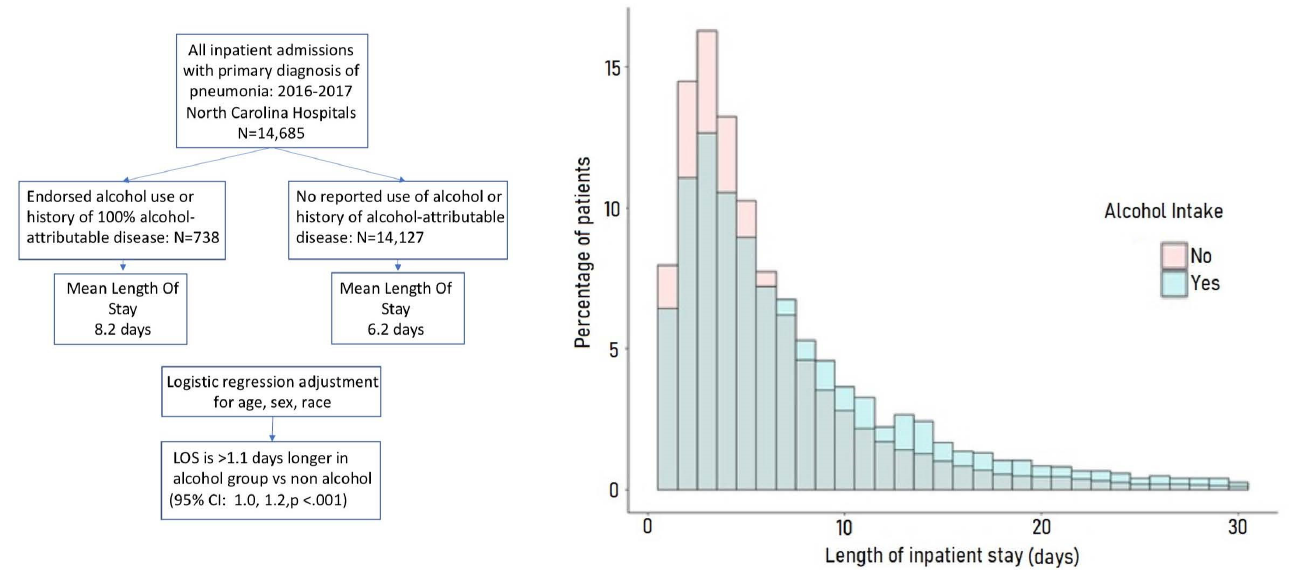
Figure 2. NC Hospital discharge data, 2016–2017. Patients in NC admitted for pneumonia with prior exposure to alcohol had extended stays, compared to those who reported no prior exposure. Multivariable linear and Poisson regression models adjusting for age, sex, and race were employed to estimate length of stay differences between the two groups.